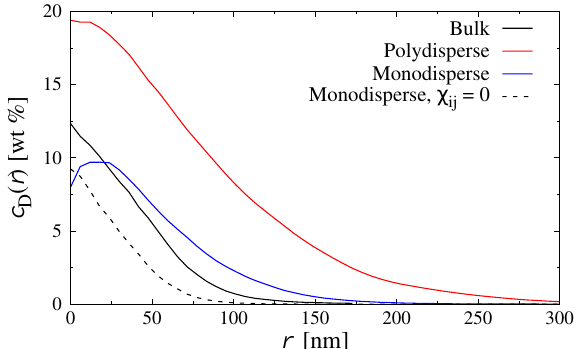
Figure 7. Radial concentration profile of Dextran monomers c D ( r ) in the largest Dextran aggregate in bulk and droplet systems ( R ≈ 380nm) at overall average concentration c P = 3wt% and c D =